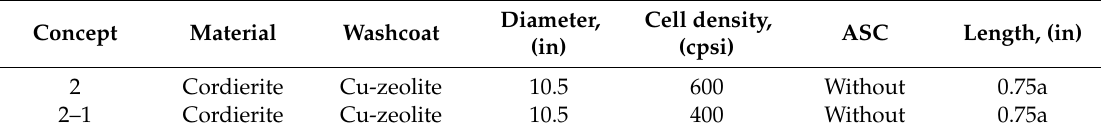
Table 3. SCR specifications for Concept 2 vs. Concept 2–1.